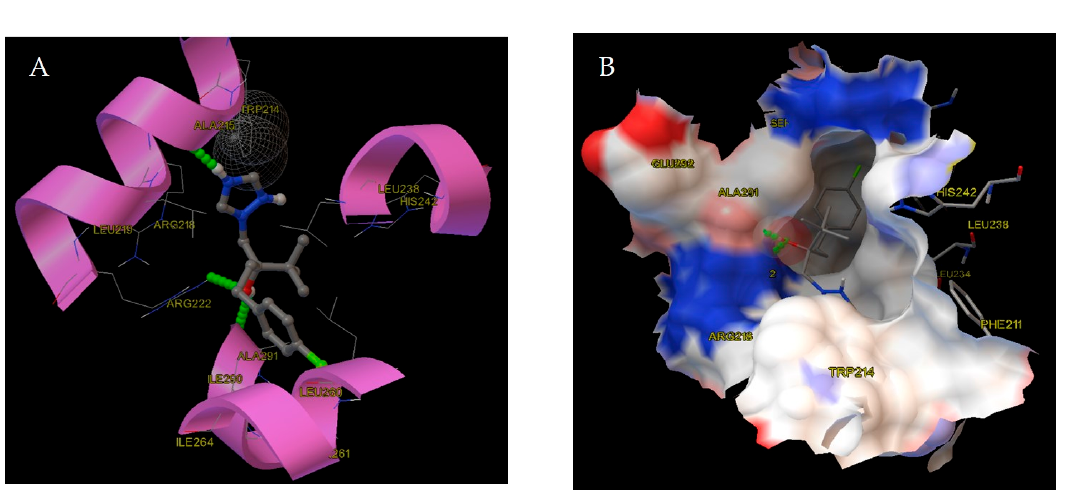
Figure 5. ( A ) Binding mode of TB to HSA. The secondary structure of the protein is shown and the neighboring amino acid residues are labeled. The hydrogen bonds are indicated by green lines. ( B ) Electrostatic potential of the ligand binding pocket in subdomain IIA (site I) of HSA. The negative and positive electrostatic potentials are colored red and blue, respectively.